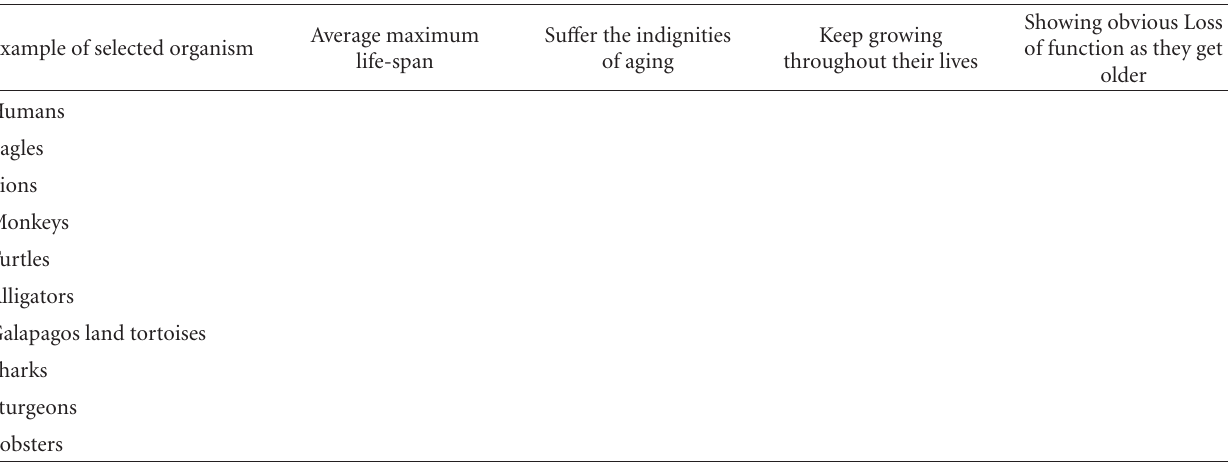
Table 7: The average life spans of selected